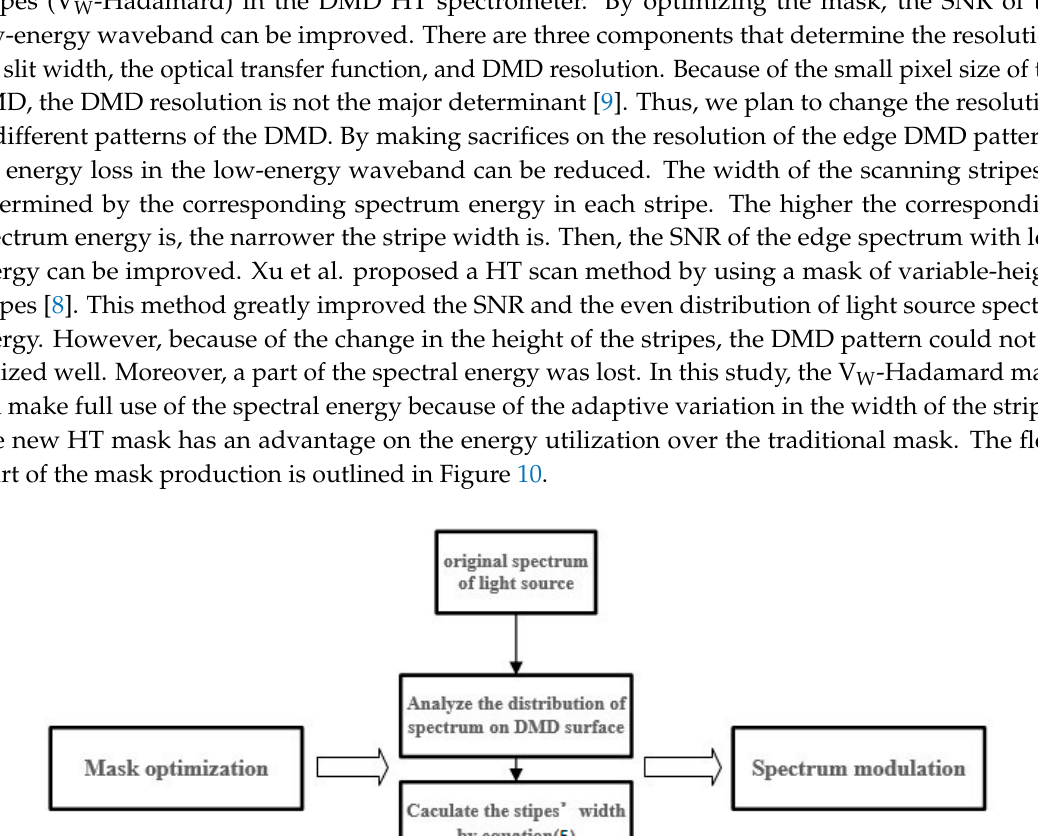
Figure 11. Hadamard masks: ( a ) traditional Hadamard mask ( b ) new Hadamard mask. They are produced by the same order of 107. Figure 12. Relative power intensity of the light source. The curves are obtained by the column scan mode with the orders of 107 and 227.